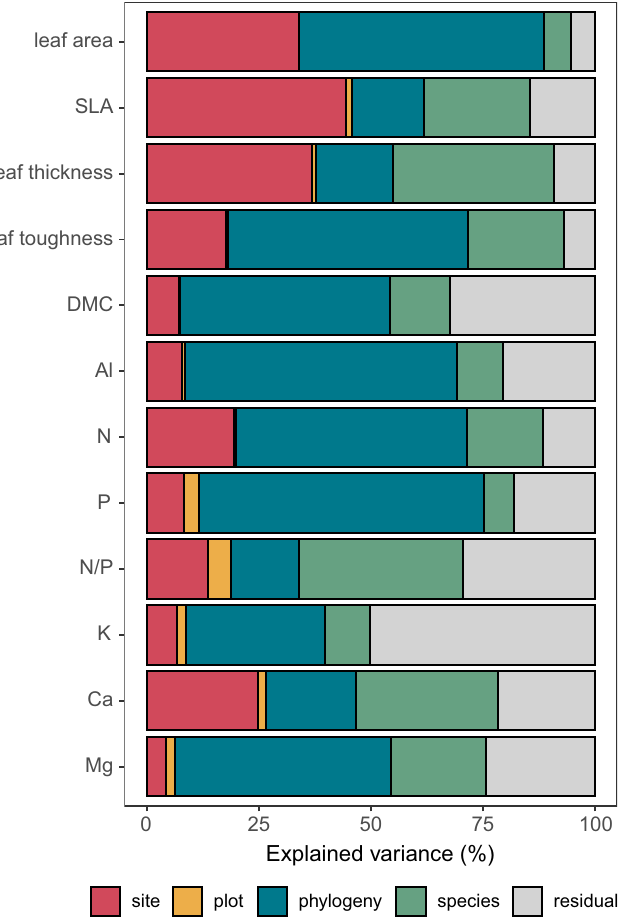
Figure 2. Fractions of variance explained by the components of the Bayesian mixed models for the 12 studied leaf